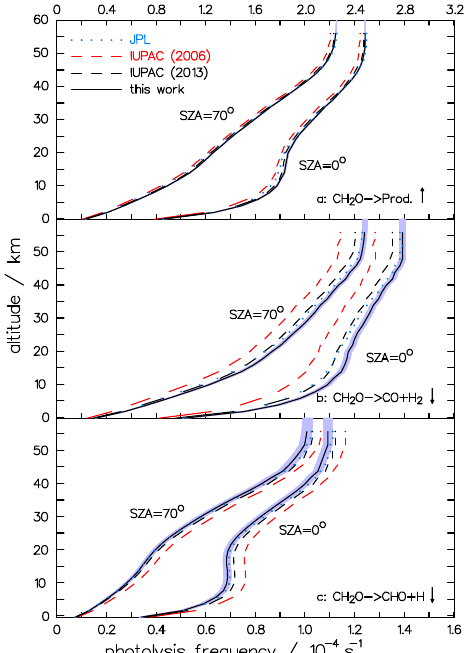
Figure 6. Comparison of the altitudinal profiles of the photolysis frequencies of formaldehyde from JPL (Sander et al., 2011), IU- PAC (2006, 2013), and the present work: total photolysis (a) , molec- ular channel (b) , and radical channel (c) . The frequencies are de- picted for two solar zenith angles (SZA). The shaded areas mark the 1 σ error bounds of the profiles based on the errors of the fitting parameters for the present quantum yields. (The arrows point to the related